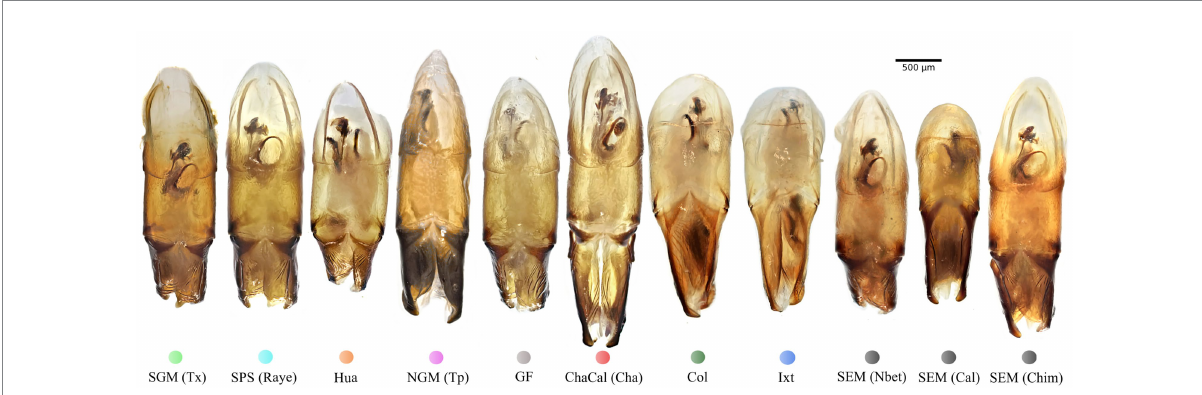
FIGURE 5 Aedeagus lateral view of specimens from the seven Mexican clades and the Colombian clade: Colored dots correspond to the clade color showed in the Bayesian tree on Figure 3.